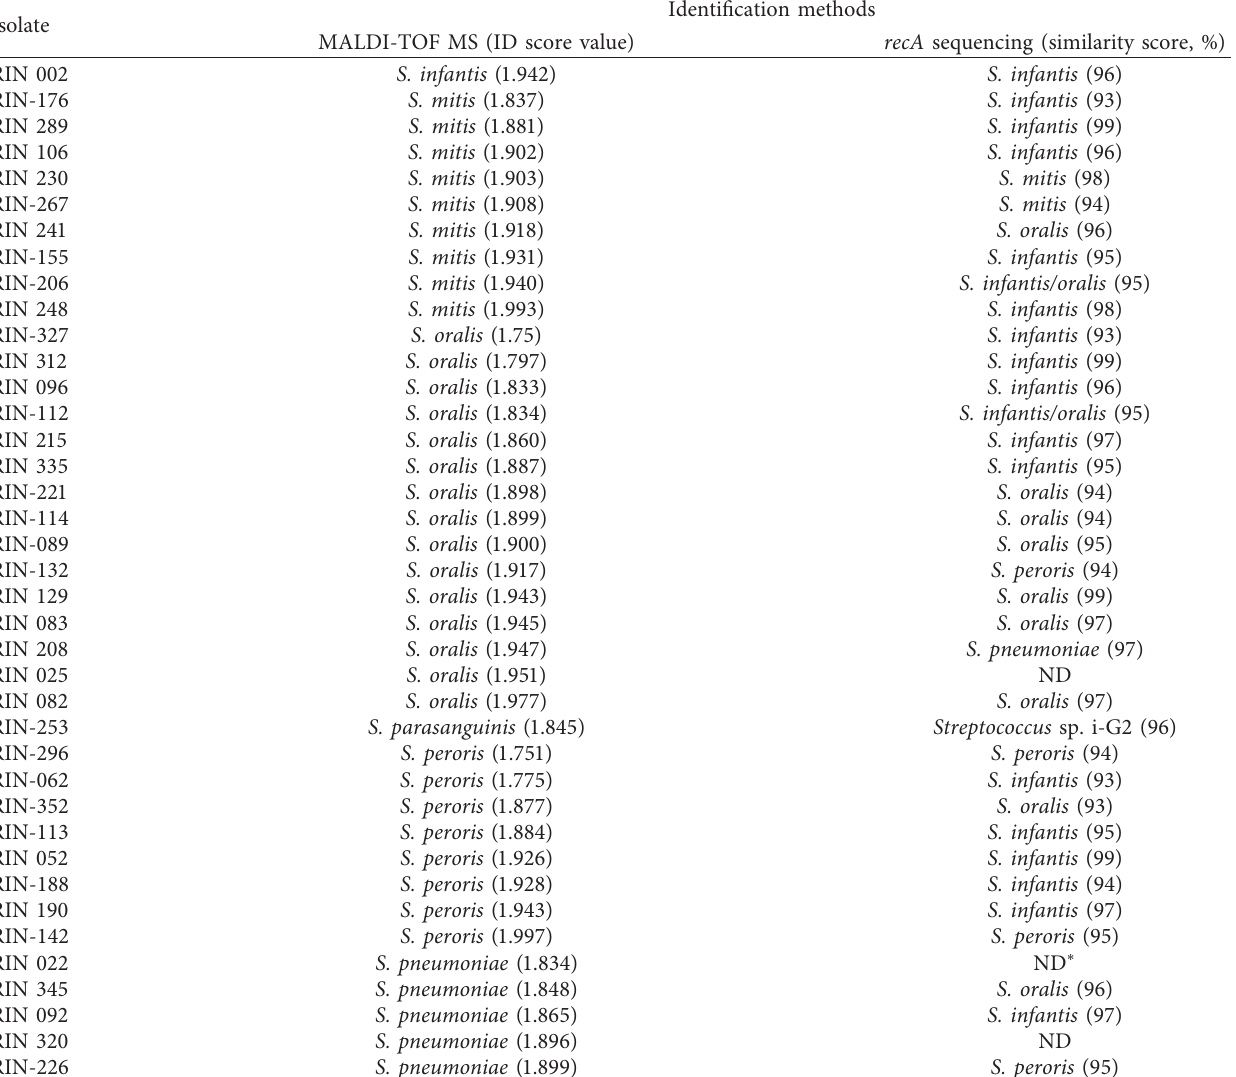
Table 2: Comparison of samples identified by MALDI-TOF with score 1.700–1.999 and recA sequence analysis.